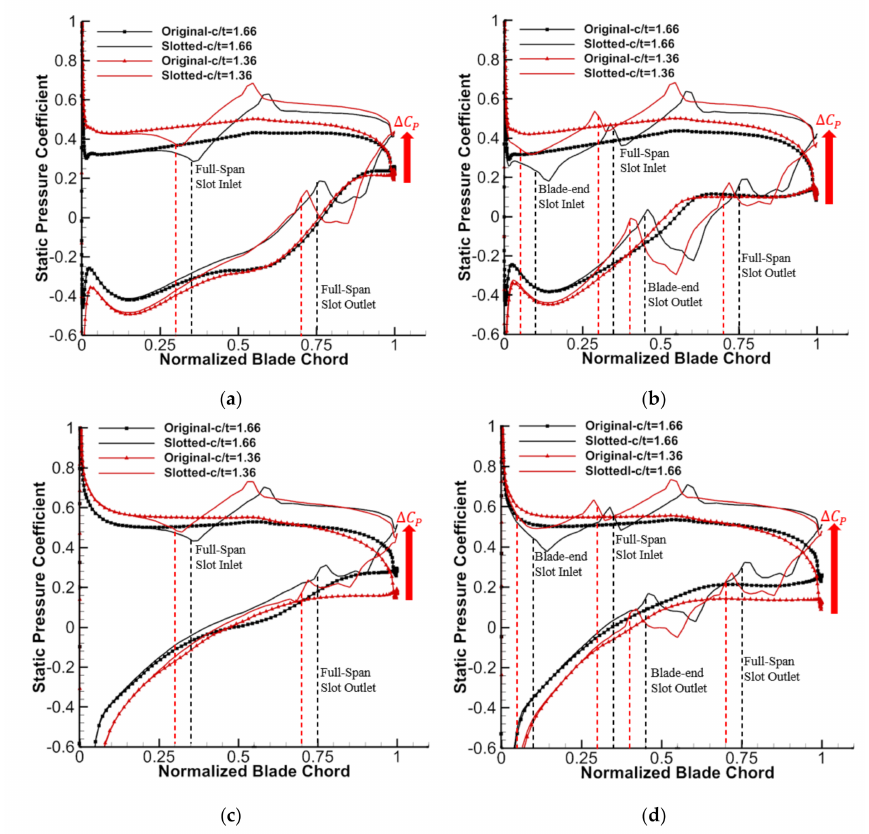
Figure 10. Static pressure coefficient distributions on the blade surfaces of the original cascade and combined slotted cascade: ( a ) 0 ◦ —50%H; ( b ) 0 ◦ —5%H; ( c ) 6 ◦ —50%H; ( d ) 6 ◦